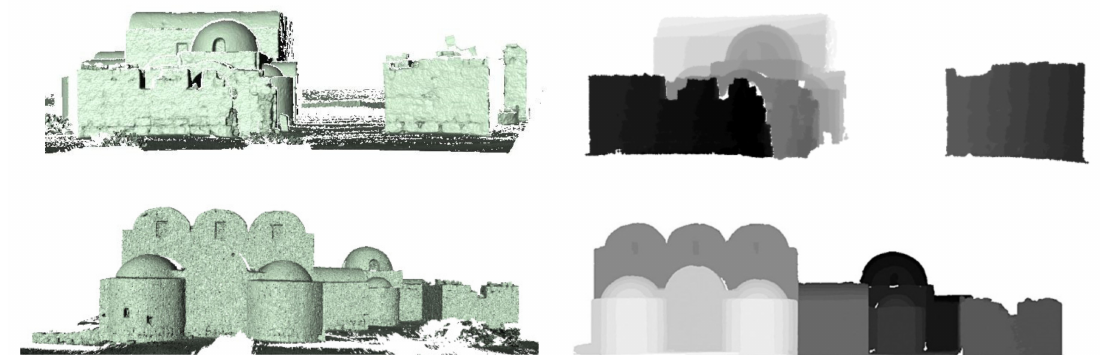
Figure 17. The flowchart of true-orthophoto.